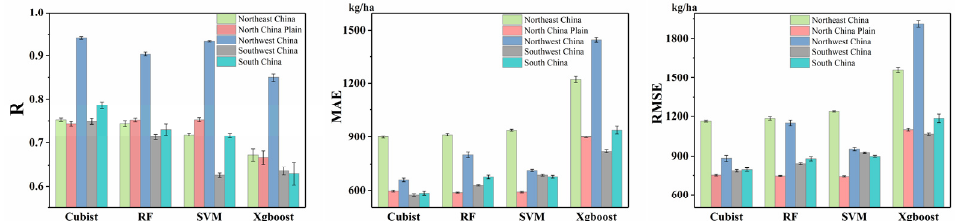
Figure 6. The model performances (estimated R values, mean absolute error (MAE), and root mean square error (RMSE)) of the different methods utilizing in five maize-growing regions. The error bars are one standard deviation of estimated R from 10 ensembles by dividing the training and testing datasets randomly.